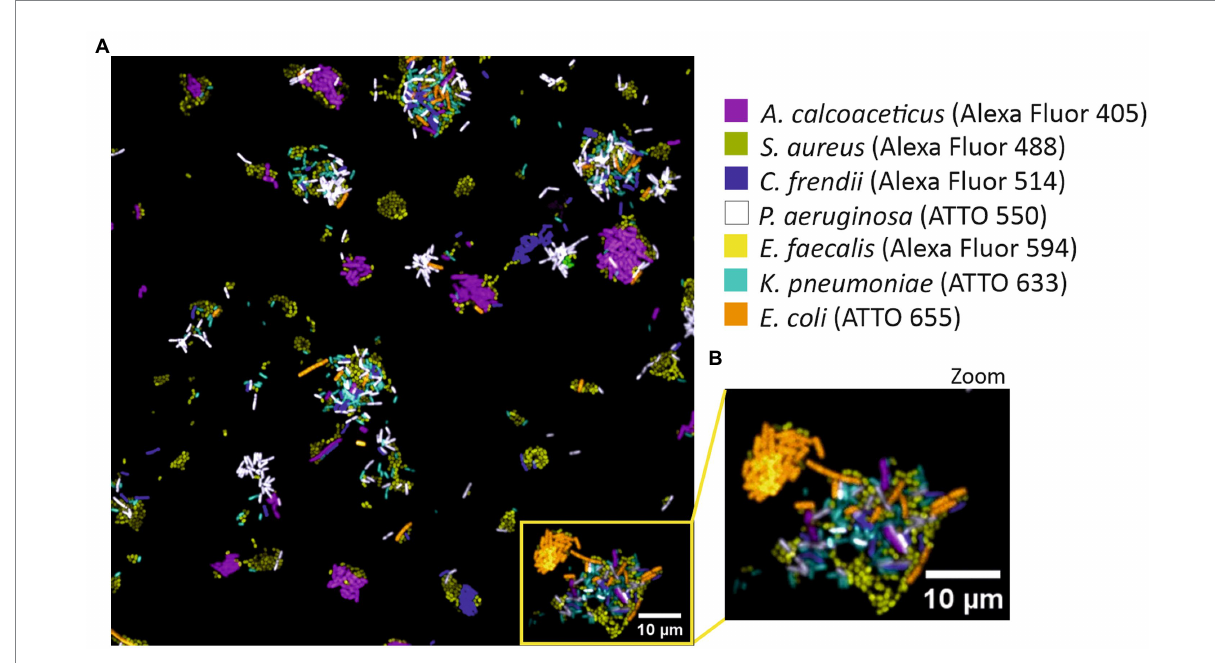
FIGURE 2 SI-NAM-FISH proof-of-principle with an EUB338 LNA/2’OMe probe attached to seven different fluorochromes. Unmixed image of a mixture of seven different bacteria labeled with an EUB338 LNA/2’OMe probe attached to ATTO 532 (magenta), Alexa Fluor 488 (green), Alexa Fluor 514 (blue), ATTO 550 (white), Alexa Fluor 594 (yellow), ATTO 633 (cyan) and ATTO 655 (orange). The image corresponds to a merge of all seven fluorochromes channels after linear unmixing (A) . Enlarged part of the image (B) as indicated by the frame in panel (A) . The bacteria, fluorochromes, and assigned false colors are